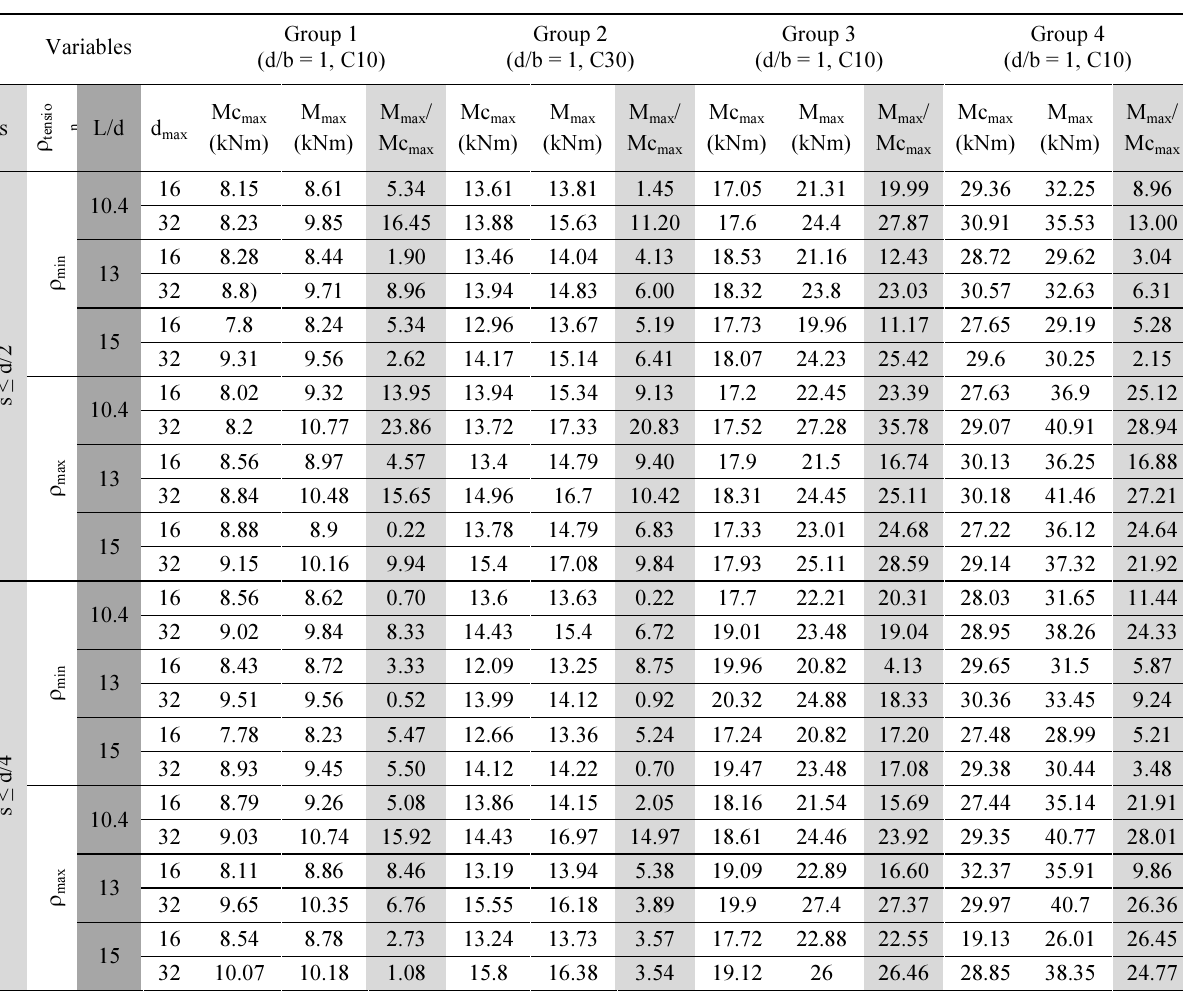
Fig. 16. Layout of numerical specimens used in parametric studies Table 8. Results of parametric